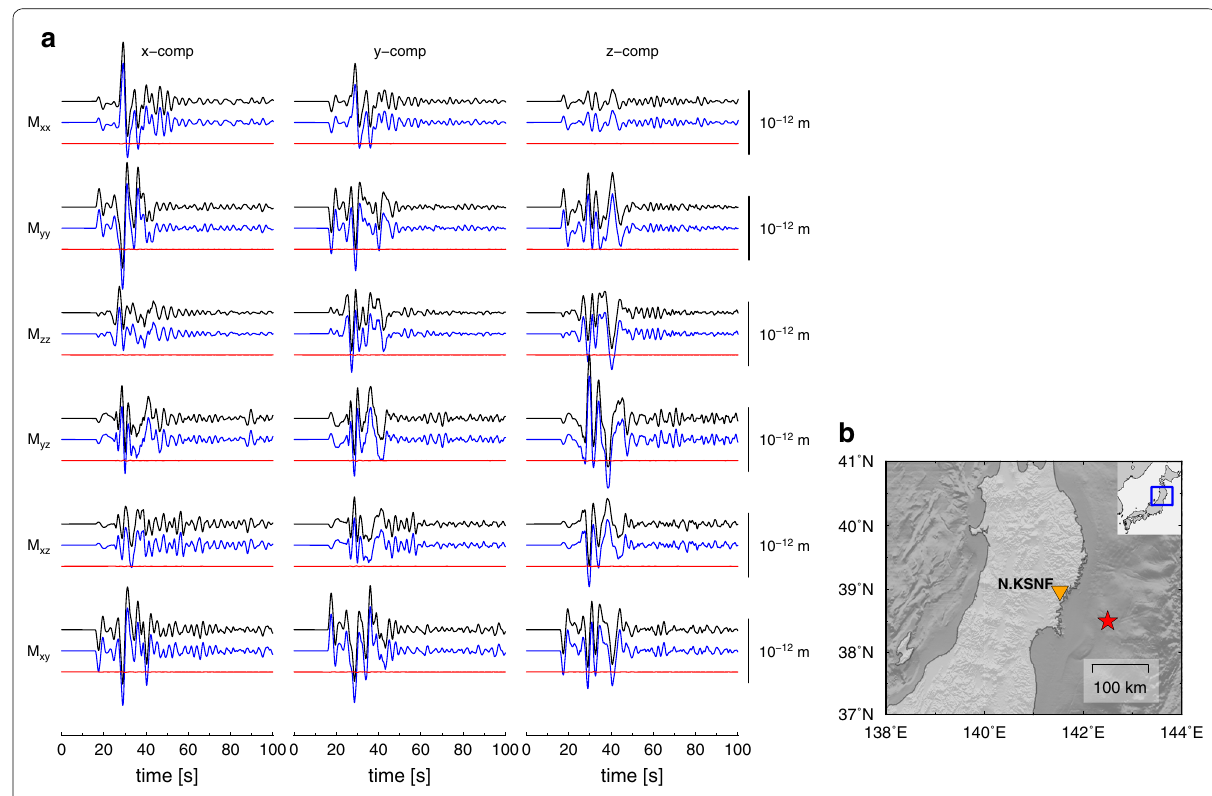
Fig. 16 An example of a computation using the reciprocity theorem. a Three-component Green’s functions of the six moment tensor components (listed on the left ). Black and blue curves represent the traces calculated using the forward simulation and the reciprocity theorem, respectively. Red curves show the residual between the forward and reciprocity calculations. b An index map showing the locations of the epicenter ( star ) and the observed station ( triangle